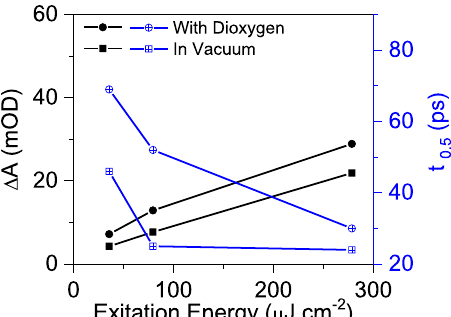
Fig. 6 The fl uence dependence of the initial amplitude (black lines and plots) and the decay half-life time (blue lines and plots) of the photo- induced electrons of PCN-NaCA-2 in glycerol aqueous solution in pure oxygen atmosphere (solid circle and plus center circle) and vacuum (solid square and plus center square) conditions. PCN-NaCA-2, polymeric carbon nitride with sodium cyanaminate